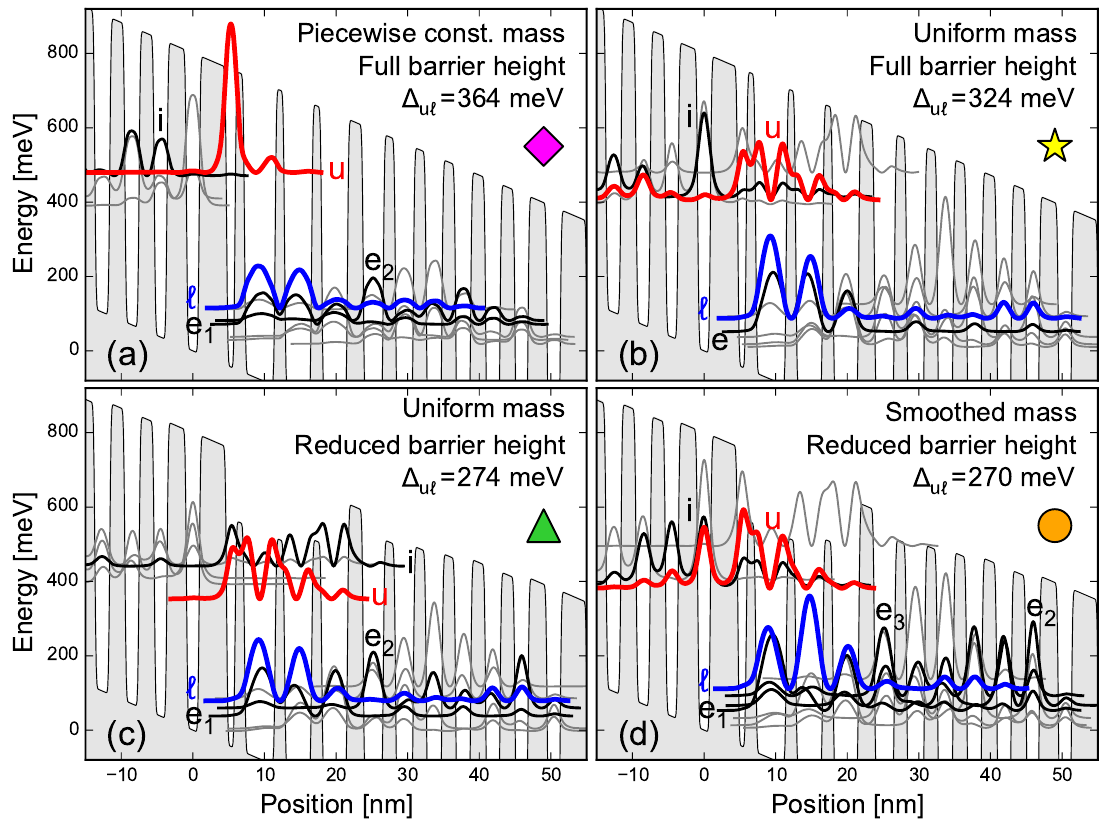
Figure 1. Calculated band structure using ( a ) piecewise constant mass with full barrier height, ( b ) uniform mass with full barrier height, ( c ) uniform mass with reduced barrier heights given by Equation (3), and ( d ) smoothed position-dependent effective mass given by Equation (4) with reduced barrier height given by Equation (3). For each case, the energy difference between upper and lower lasing levels ∆ u (cid:96) is given. Labels identify the upper lasing level (u); lower lasing level ( (cid:96) ); most effective injector state (i), often referred to as the ground state; and notable extractor states ( e 1 , e 2 and e 3 , in increasing order of energy). The symbols (diamond, star, triangle, and circle) refer to the corresponding J – F curves in Figure